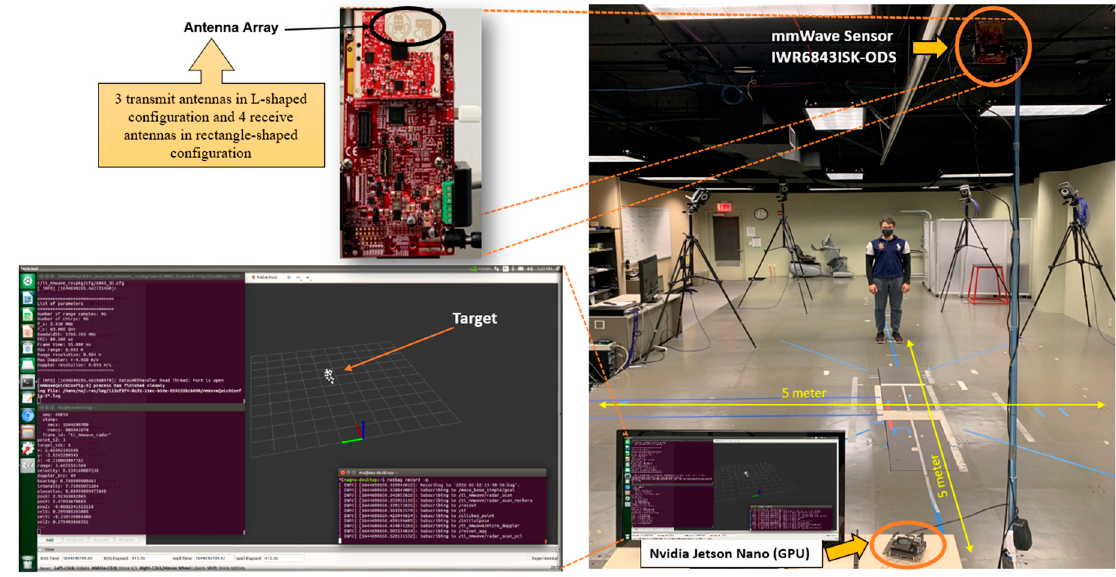
Figure 8. Experiment Setup.